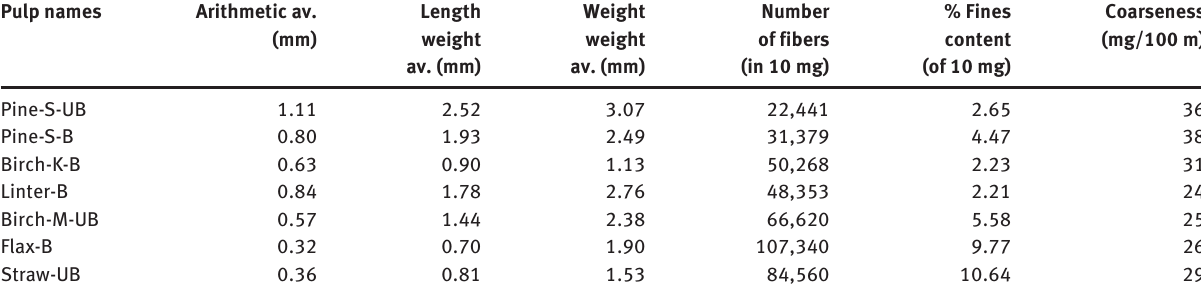
Table 4 Some parameters of unbeaten pulps revealed by Kajaani FS